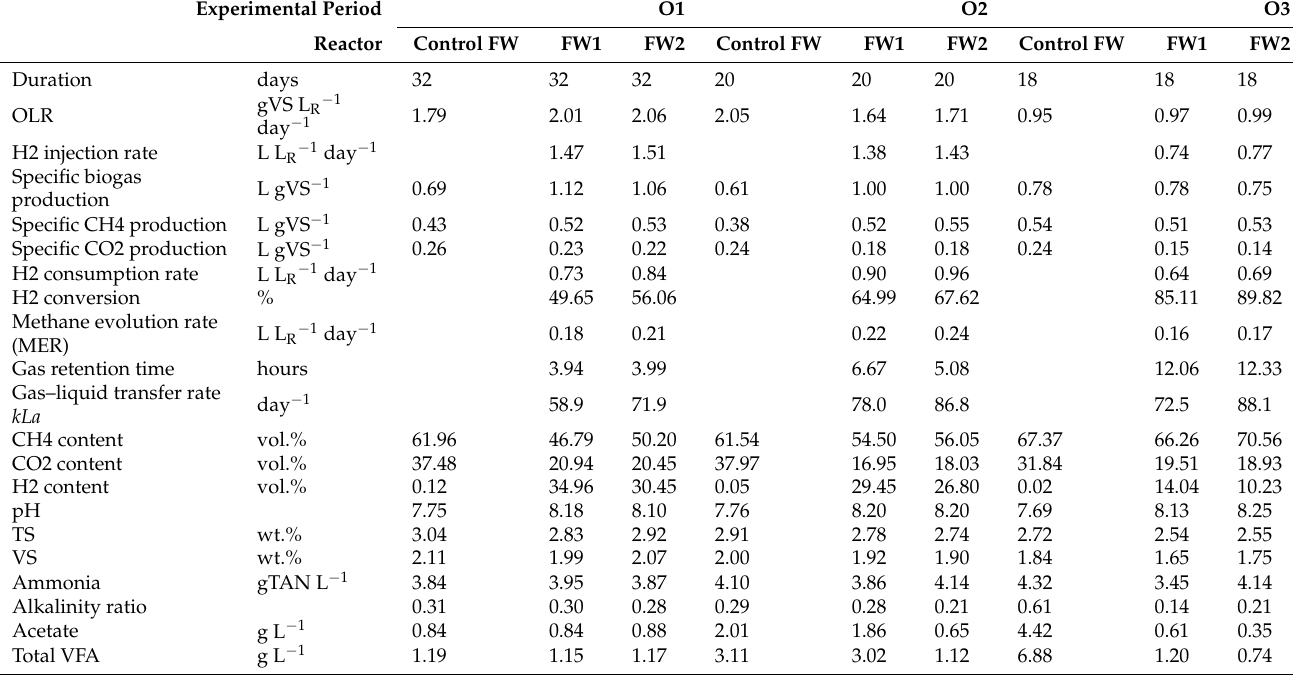
Table A7. Average in-situ biomethanation results for food waste (FW)-fed reactors across operational periods